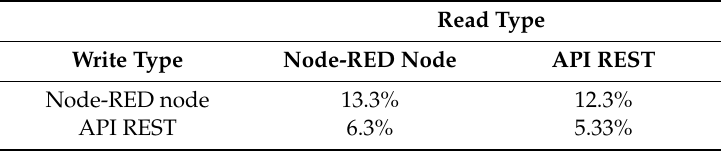
Table 6. Percentage of database access with L CDC greater than 5 s.